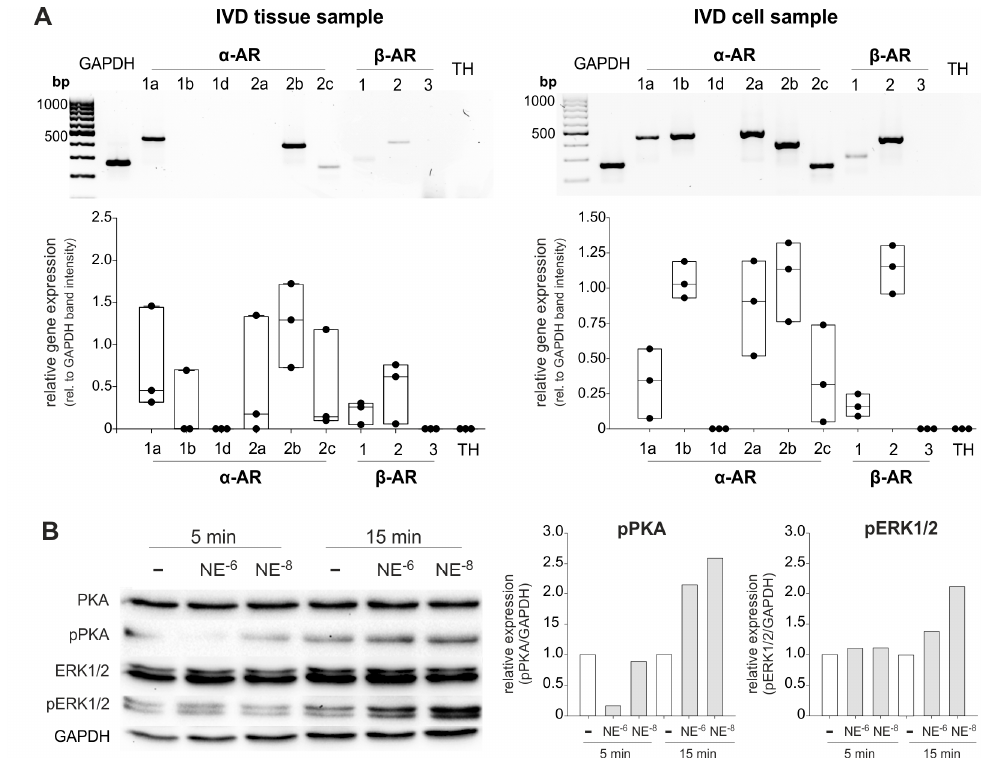
Figure 6. AR gene expression and NE-mediated activation of intracellular signaling pathways in human IVD cells. ( A ) Gene expression of different AR subtypes in untreated primary IVD cells isolated from three patients (representative RT-PCR image of one IVD donor) compared to the respective tissue sample. ( B ) Changes in PKA and ERK1/2 phosphorylation in isolated IVD cells after treatment with low or high NE concentrations (10 − 8 or 10 − 6 M) after 5 or 15 min (( n = 3); representative Western Blot images of cells isolated from one IVD donor). The expression of phosphorylated kinases (pPKA and pERK1/2) is shown relative to GAPDH expression (set as 1). White boxes indicate untreated controls, the grey boxes the NE-treatment groups.